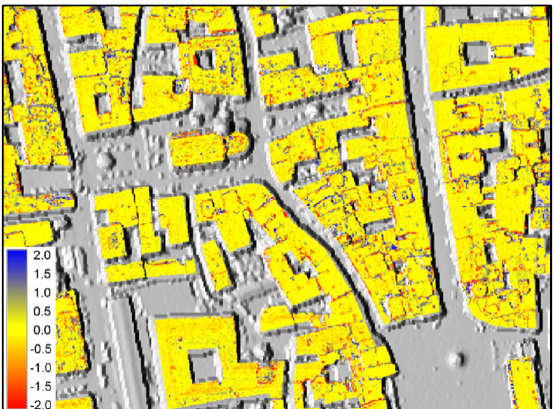
Figure 4: Difference map (in metres) between the LiDAR and photogrammetric DSMs (cell resolution: 0.5 m). A grey-coded shaded relief map of the DSM is shown as background for reference.